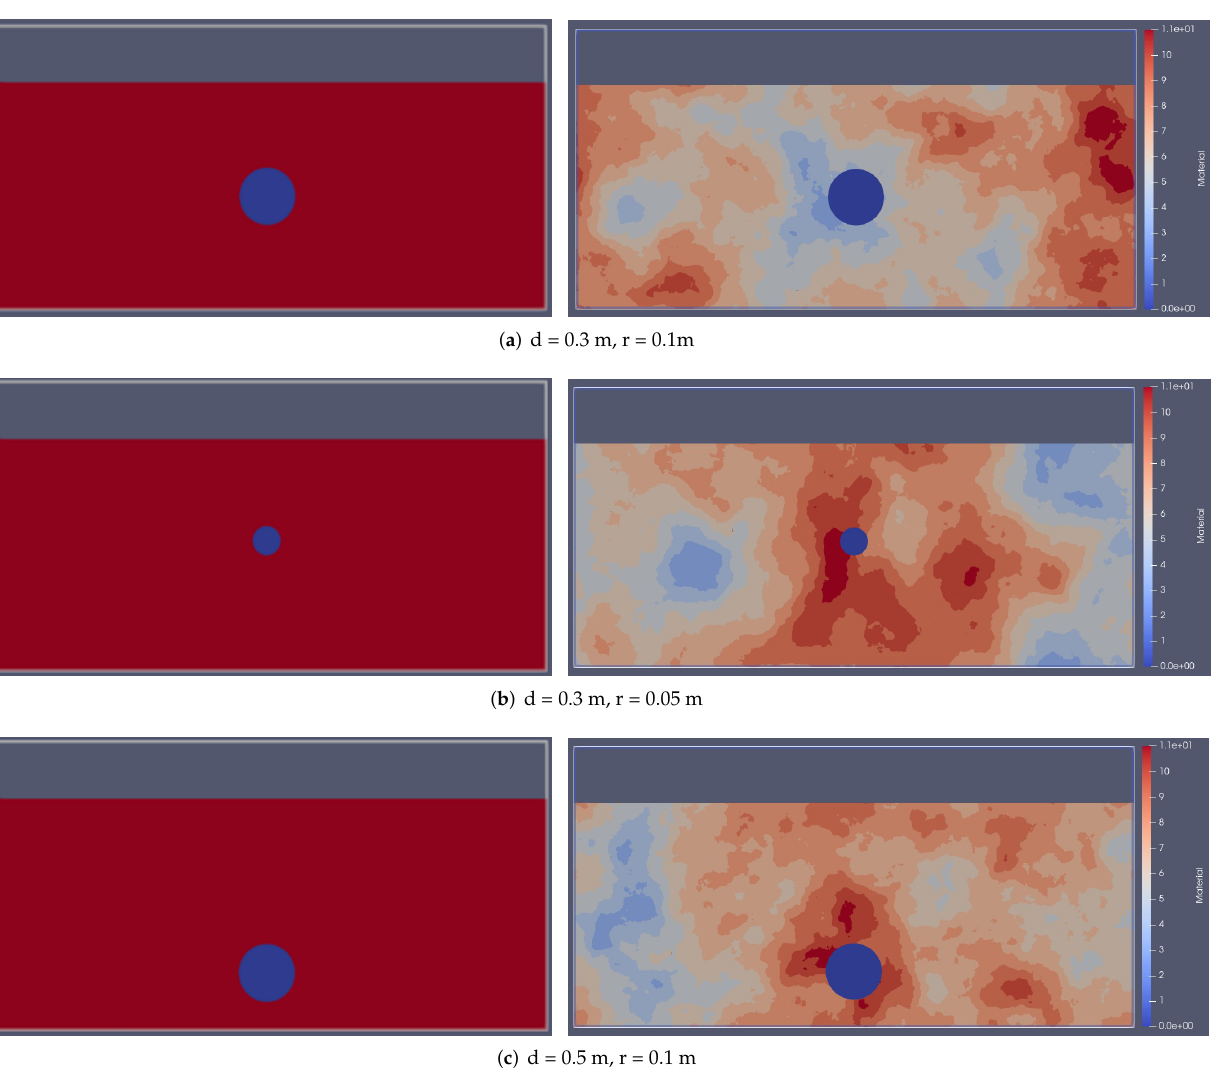
Figure 10. Model